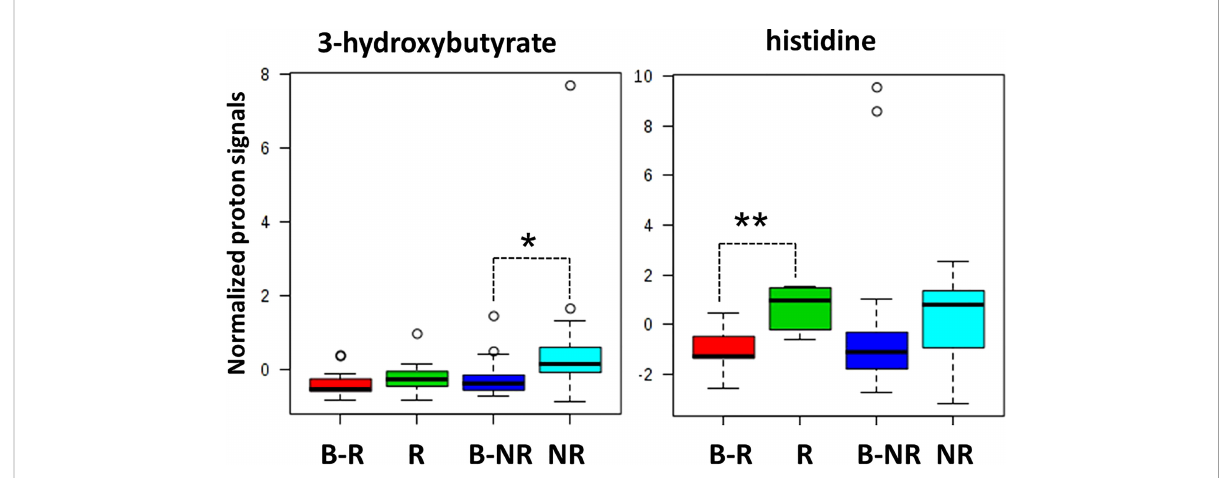
FIGURE 4 Box and whisker plots summarize the normalized values of 3-hydroxybutyrate and histidine evaluated at both baseline (B-R and B-NR) and at response evaluation (R and NR) (* p-value=0.042; ** p-value=0.001).